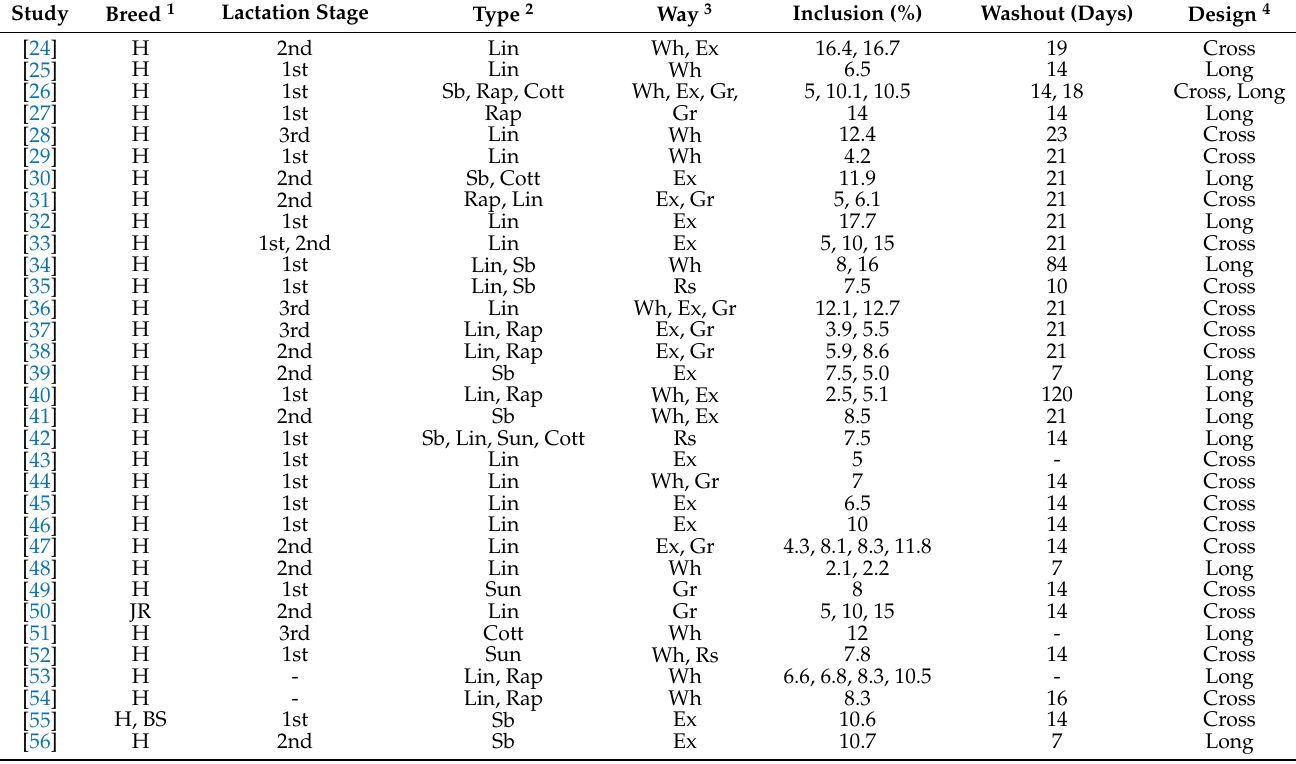
Table 1. Studies, characteristics of animals and oilseed, inclusion, washout and experimental design included in